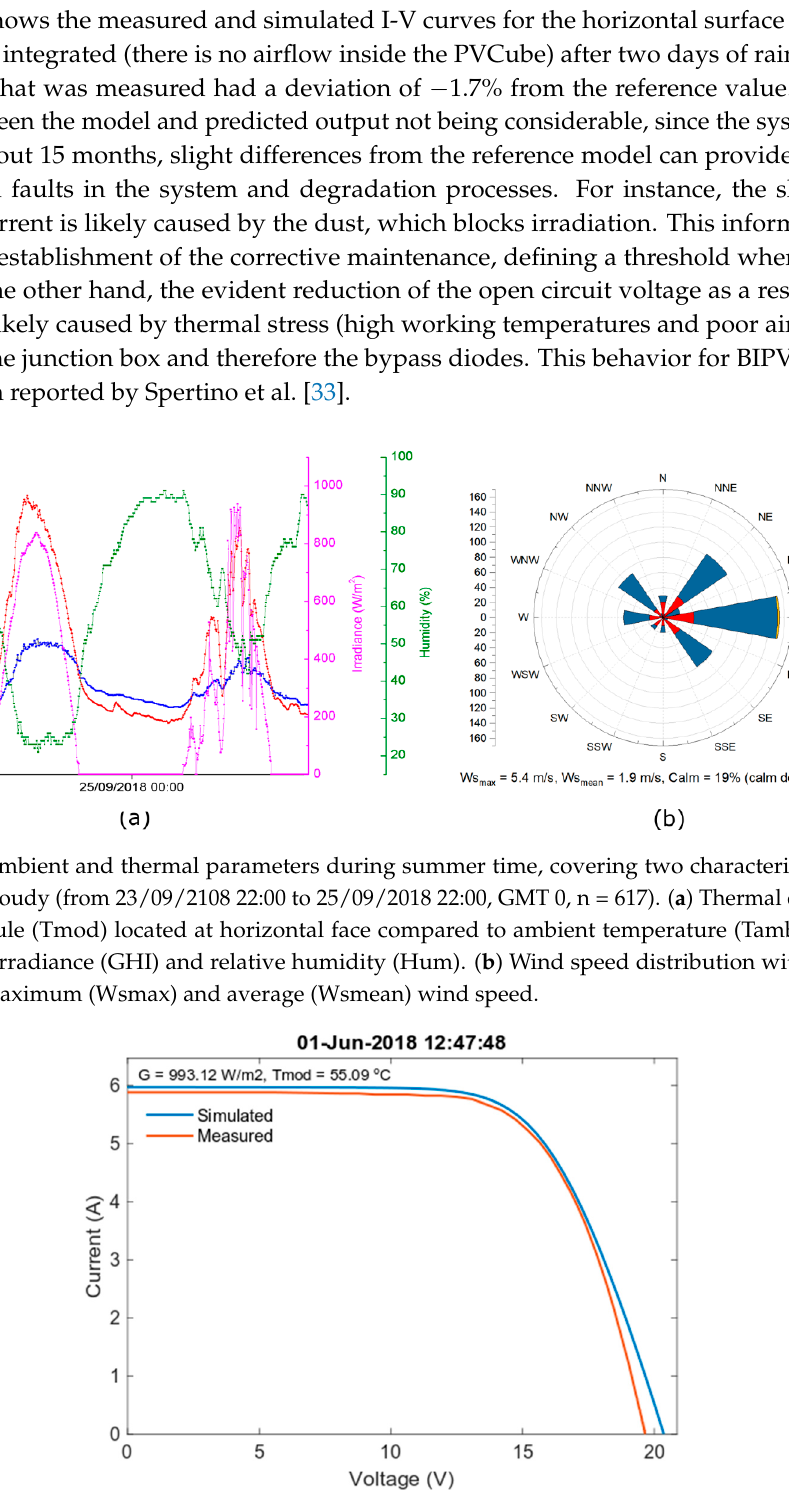
Figure 6. Measured and simulated I-V curves for the horizontal surface when the PV module is fully integrated after two days of rainfall. A small reduction of photocurrent is detected when compared to the model (and to the just-cleaned module).